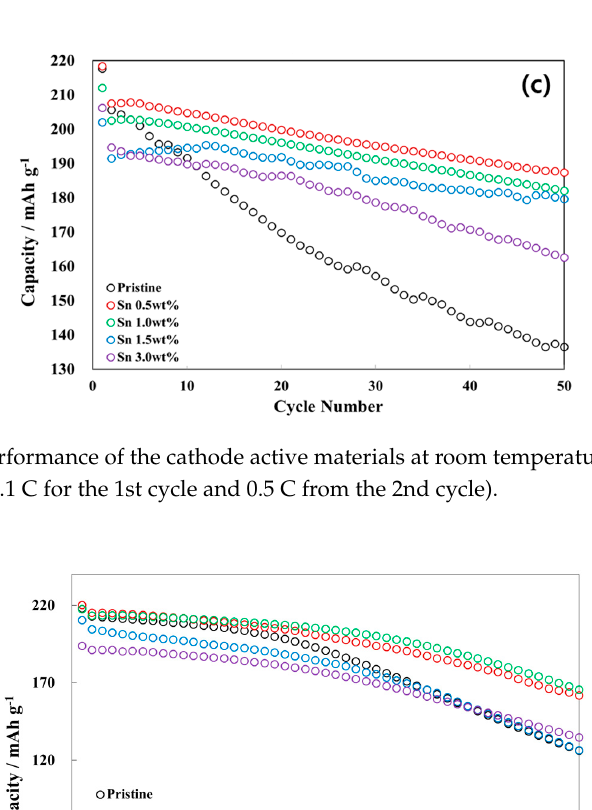
Figure 9. Cycling performance of the cathode active materials at high temperature (60 °C) and 0.5 C (0.1 C for the 1st cycle and 0.5 C from the 2nd cycle).